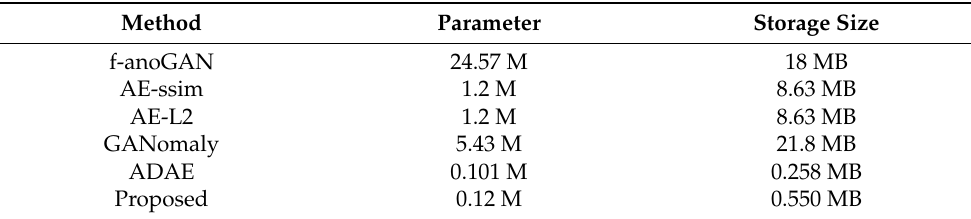
Table 7. Quantitative comparisons with other methods (parameter and